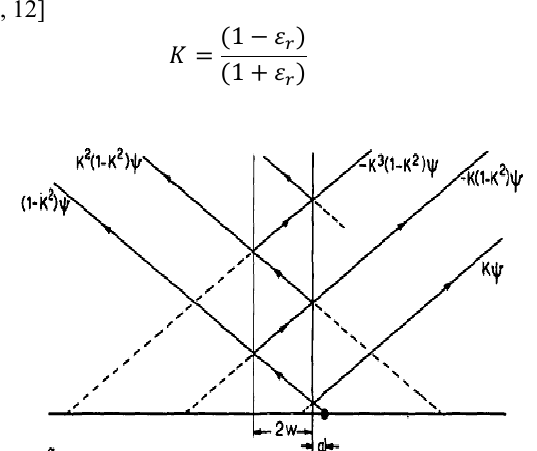
Figure 2: Multiple images of a line charge in front of a dielectric slab